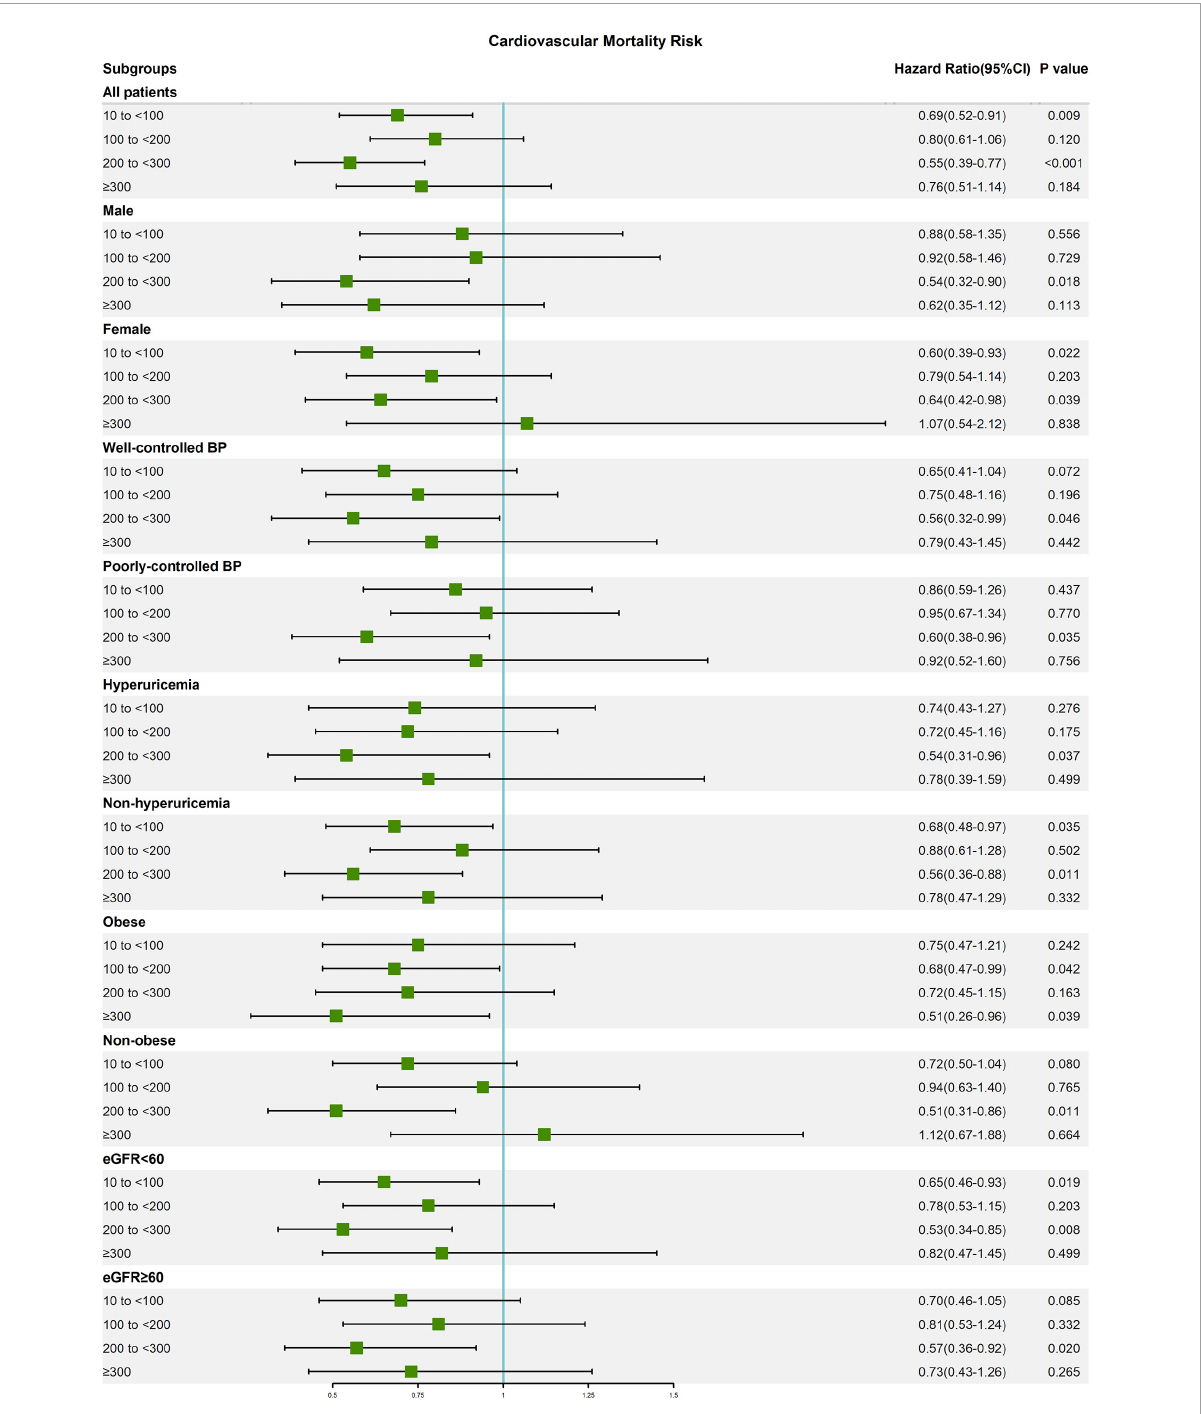
FIGURE3 Forest plot of multivariable model 3 hazard ratios for cardiovascular mortality in subgroup